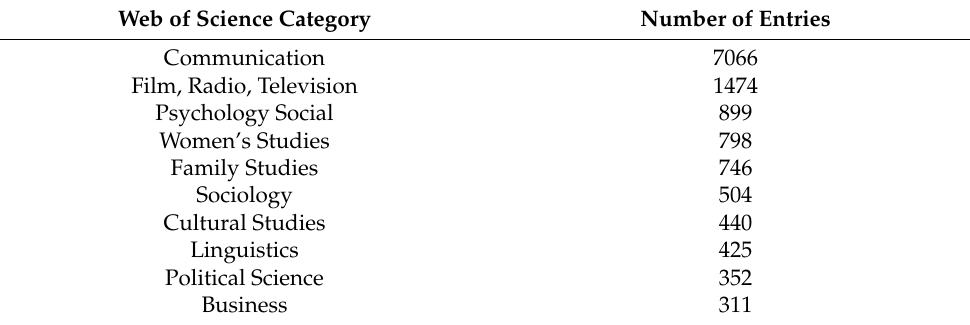
Table 2. Top 10 Web of Science categories. Web of Science